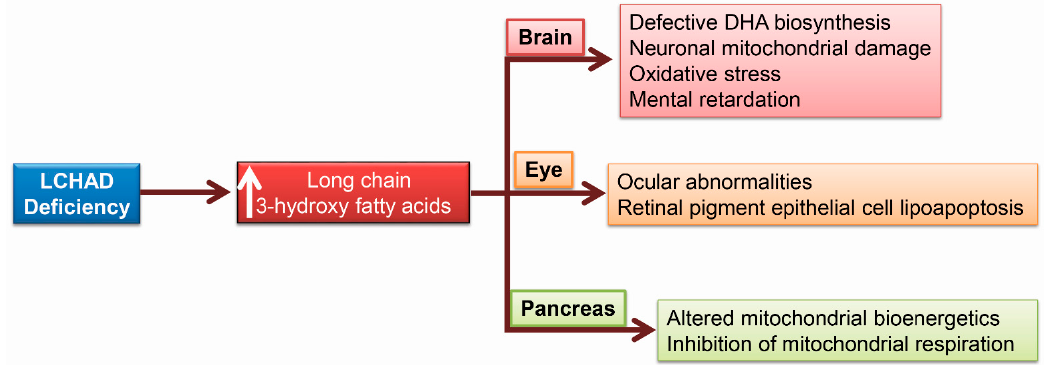
Figure 3. Other complications due to 3-hydroxy fatty acid (3-HFA) accumulation. LCHAD deficiency in children results in docosahexenoic acid (DHA) deficiency and 3-HFA accumulation induces neuronal mitochondrial and oxidative damage in the brain. LCHAD deficiency was also associated with ocular abnormalities and retinal pigment epithelial cell lipoapoptosis. In the pancreas, 3-HFA alters mitochondrial bioenergetics in the islet β -cells.